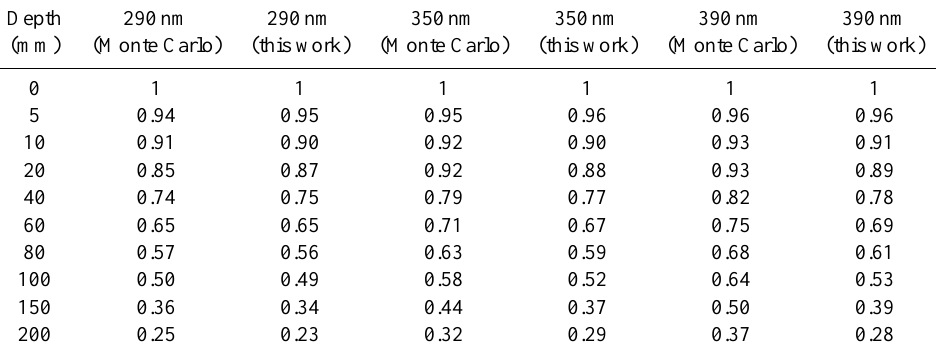
Table D4. Comparison of snowpack actinic flux profile for Summit, Greenland, using our parameterization and a Monte Carlo radiative transfer model (Peterson et al., 2002) for stratified snowpack with ρ snow ranging from 260–390kgm − 3 , snow grain diameter ranging from